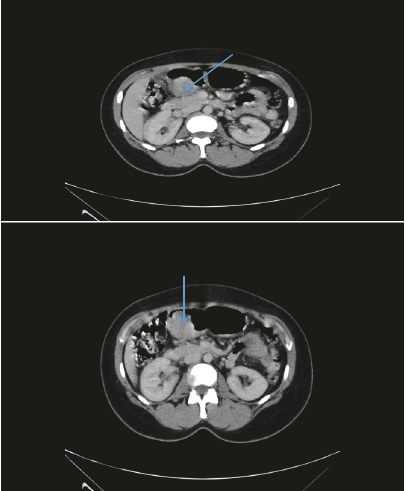
Figure 1: Axial images of CT scan of abdomen revealing mass in gastric antrum near pylorus.